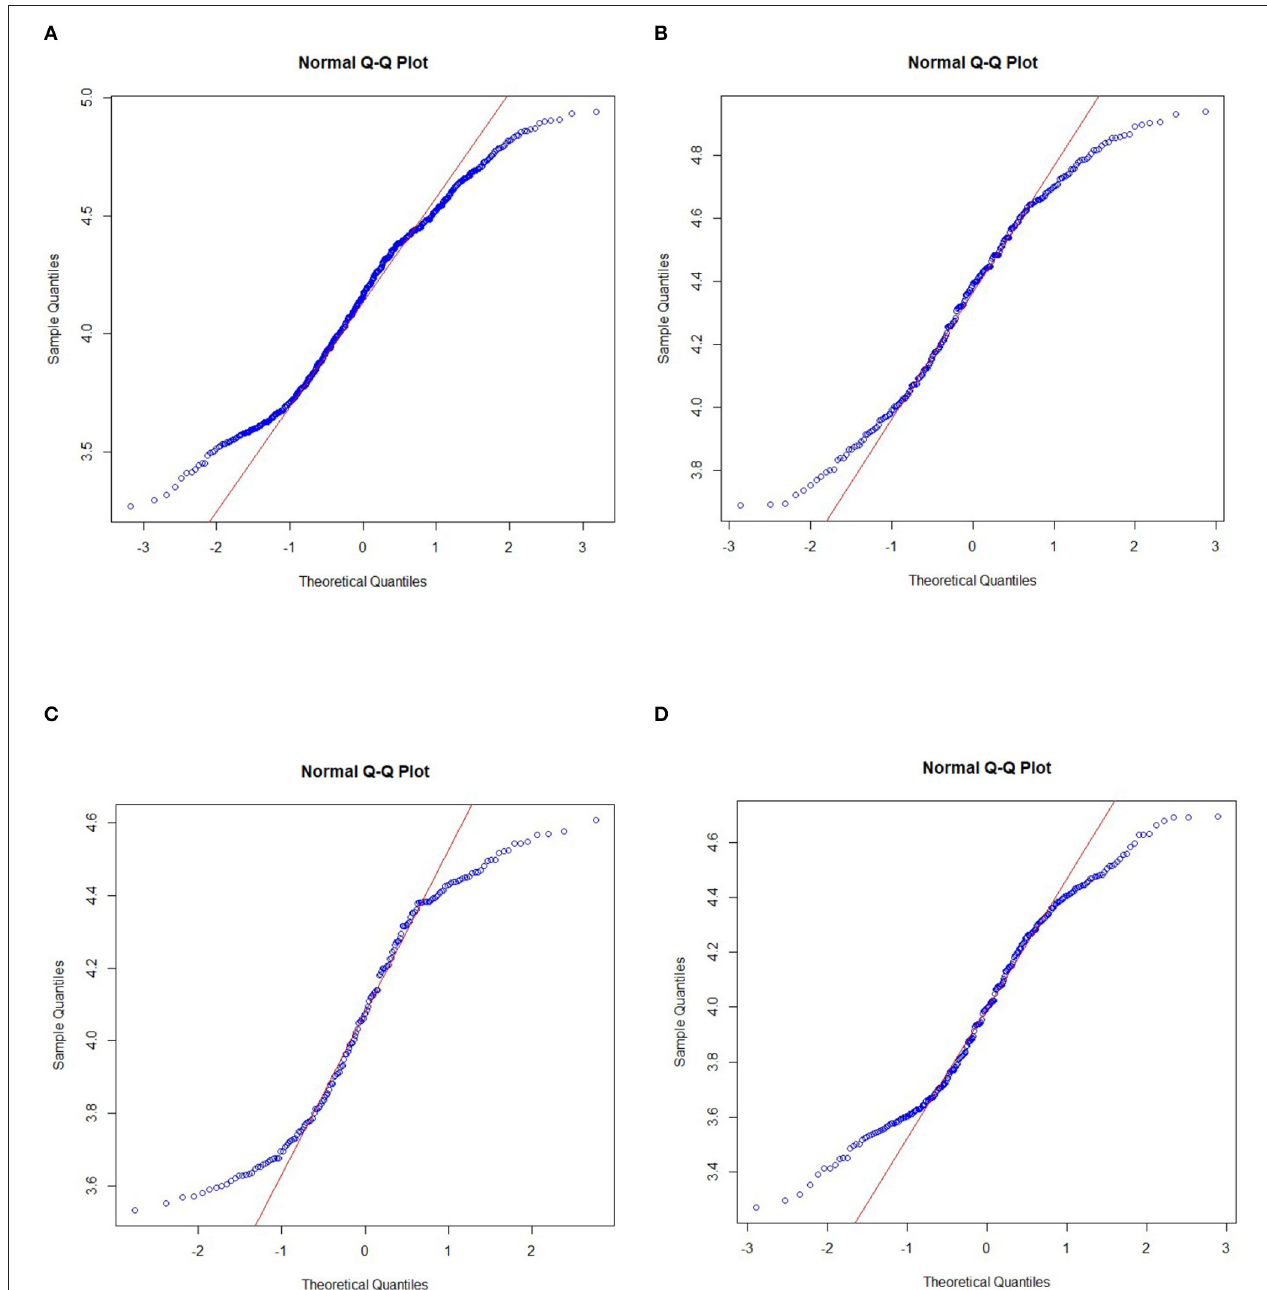
FIGURE 2 | Q–Q plot of the normality test for the whole country and the eastern, central and western regions. (A) National Q–Q plot, (B) Eastern region Q–Q plot, (C) Central region Q–Q plot, and (D) Western region Q–Q